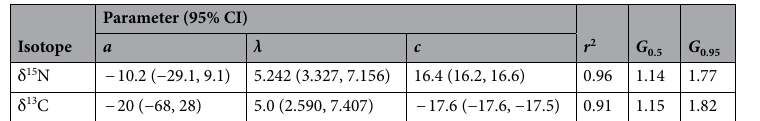
Parameter (95% CI)